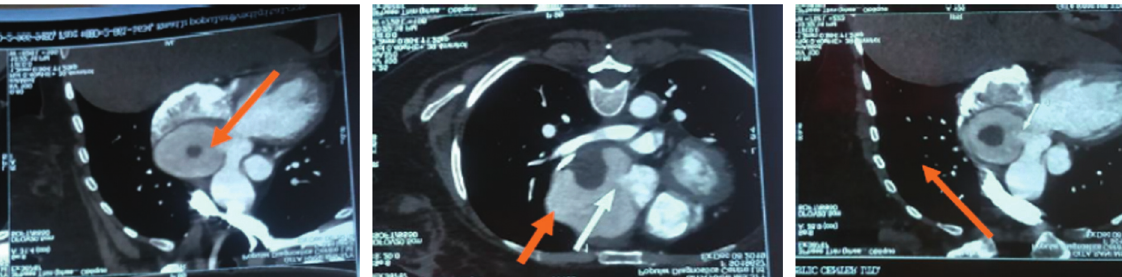
Figure 2: CTangiogram of the heart and great vessels. Large eccentric structure is noted in the root of the ascending aorta having fistulous communication. A hypodense area is noted within the structure. The structure is compressing the corresponding superior vena cava and left ventricular outlet or aortic root (7.5mm), suggestive of large aneurysm at the aortic root containing the thrombus. Photo: courtesy of the